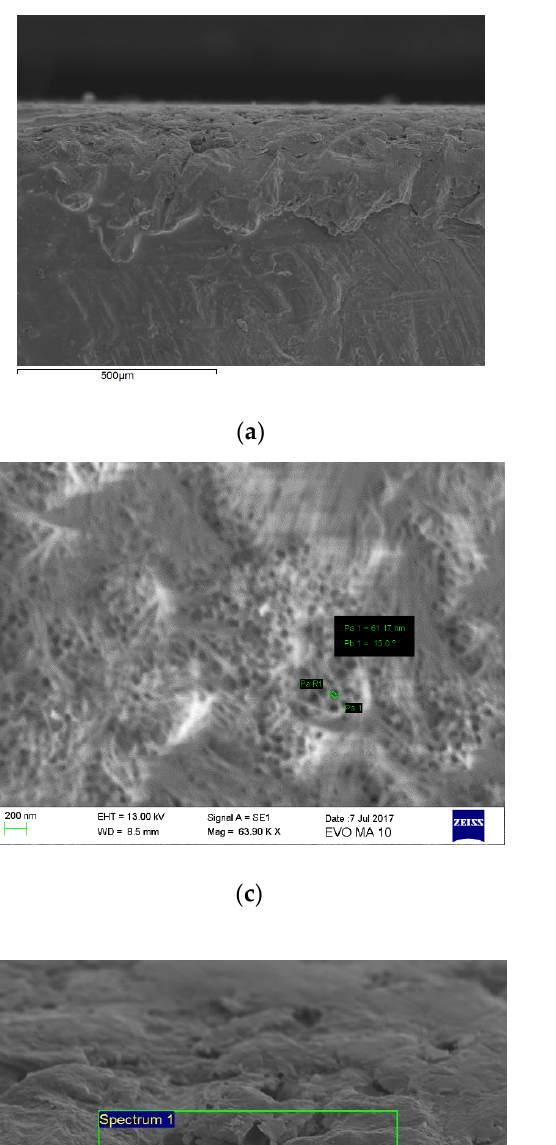
( c ) Figure 3. Experimental setup of a single-lap joint for ( a ) tensile – shear loading with tabs visible, ( b ) tensile – shear loading during experiment and ( c ) flexural loading during a three-point bending experiment. 3. Results and Discussion 3.1. Anodization Results A new recipe that enables the formation of alumina nanotubes on commercial alumi- num plates was found. The anodization protocol within the present investigation emerged after many trial and error experiments and after combining several literature- recommended recipes [23 – 26]. By applying the above-mentioned protocol of hard anodization, an alumina nano- tubes layer (Figure 4d) was shaped on the aluminum plates. The surface topography of the substrate after the several anodization steps of the protocol may be seen in Figure 4a – c. Nanotubes cannot be seen clearly prior to ultrasonication (Figure 4c). The pore widen- ing and the elimination of chemical traces from the electrolyte was achieved by applying